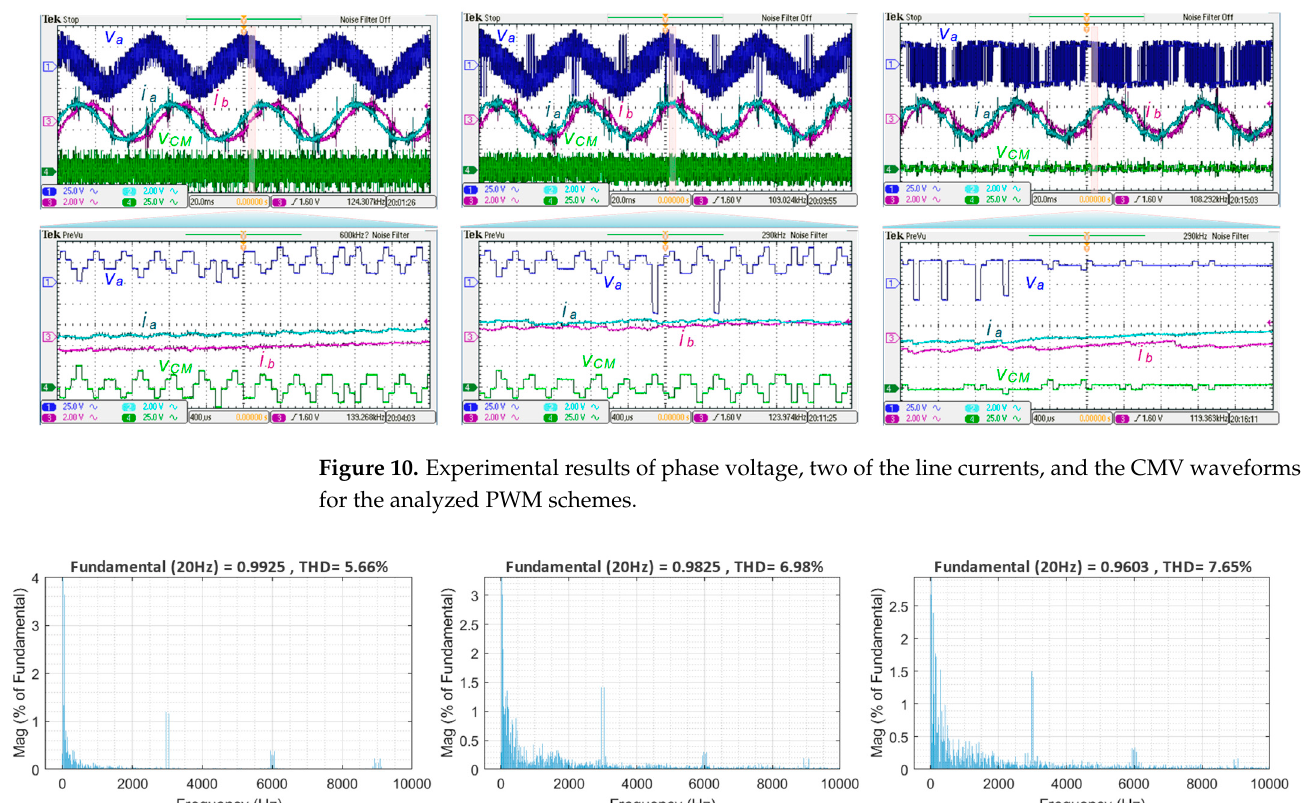
Figure 10. Experimental results of phase voltage, two of the line currents, and the CMV waveforms for the analyzed PWM schemes.